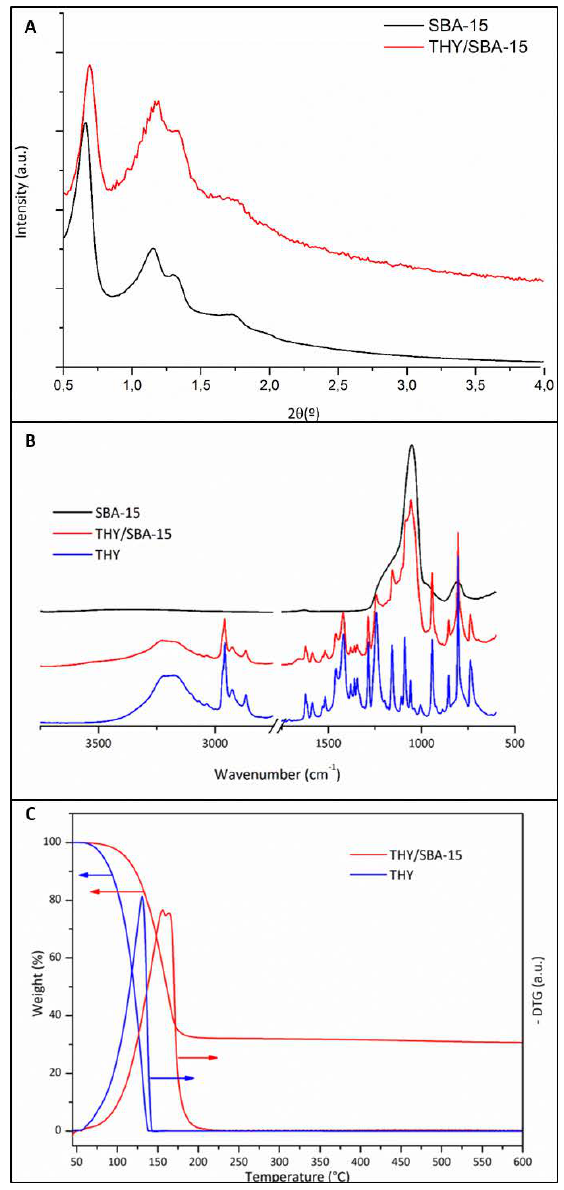
Figure 2. ( A ) Small Angle X-Ray diffraction pattern for SBA-15 NPs and SBA-THY NPs, ( B ) IR spectra of SBA-15 NPs, SBA-THY NPs and thymol, ( C ) TGA and DTGA of THY and THY/SBA-15 NPs.